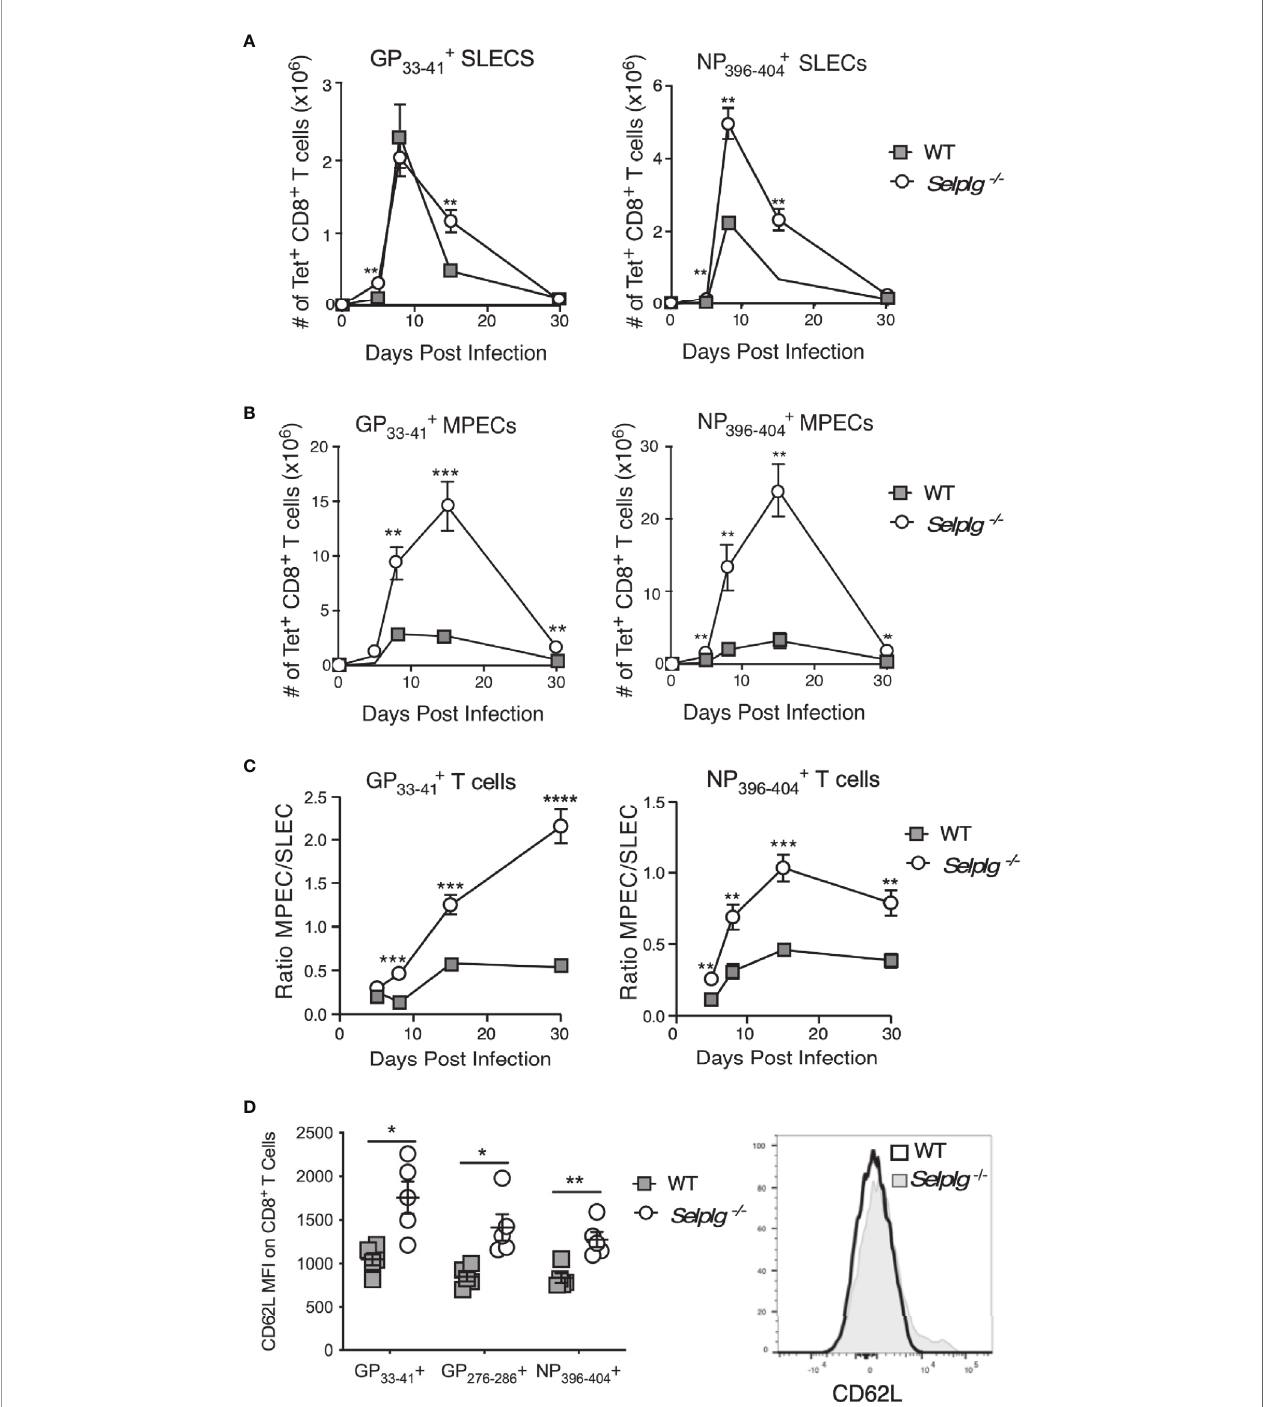
FIGURE 3 | Virus-speci fi c CD8 + T cells in Selplg -/- mice are enriched for memory precursor and central memory phenotype cells. WT and Selplg -/- mice were infected with LCMV Arm and the numbers of short-lived effector phenotype cells (SLECs: IL7R a - , KLRG-1 + ) (A) and memory precursor effector cells (MPECs, IL-7R a + , KLRG-1 - ) (B) were evaluated for GP 33 − 41 + CD8 + T cells and NP 396 − 404 + CD8 + T cells in the spleens. (C) The ratios of MPEC to SLEC phenotype CD8 + T cells for each of the tetramer+ populations. (D) Expression levels (MFI) of CD62L on CD8 + tetramer + T cells from the spleens at 30dpi, with a representative histogram for GP 33 − 41 + CD8 + T cells. Data are representative of three independent experiments (n = 5 or more mice/group). Graphs show the mean ± SEM * p < 0.05, ** p < 0.005, *** p < 0.001, **** p < 0.0001 by two-tailed t-